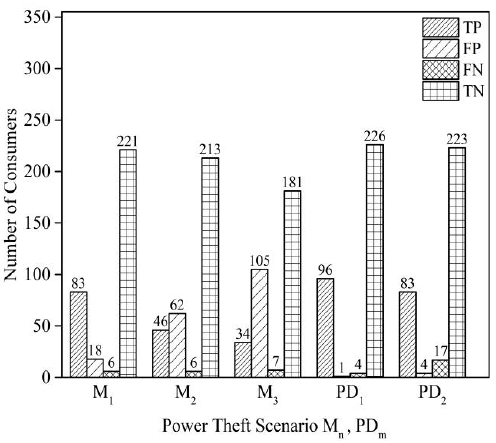
Figure 6. Confusion matrix for overload power theft scenarios (O k ).